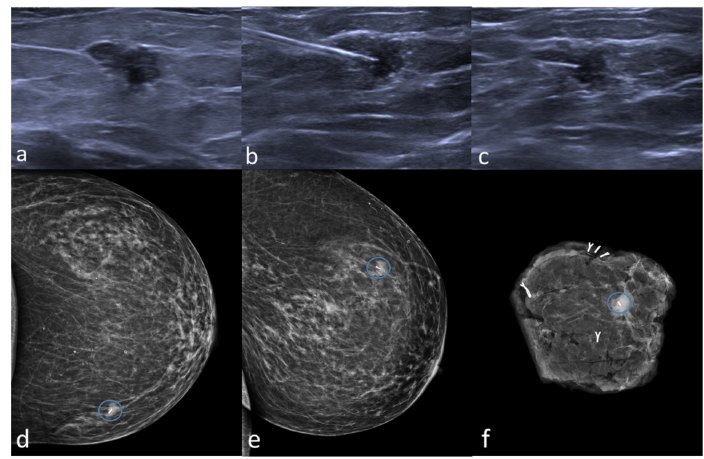
Figure 3. Magseed placement under ultrasound guidance. Preoperative ultrasound localization of a non-palpable, hypoechoic lesion (invasive ductal carcinoma) in the left upper inner quadrant ( a ), and placement of Magseed inside the lesion ( b , c ). Preoperative mammogram in two views confirms the correct placement of the Magseed (blue circle, d , e ). The surgical specimen shows the presence of both the tumor and Magseed (blue circle, f ).